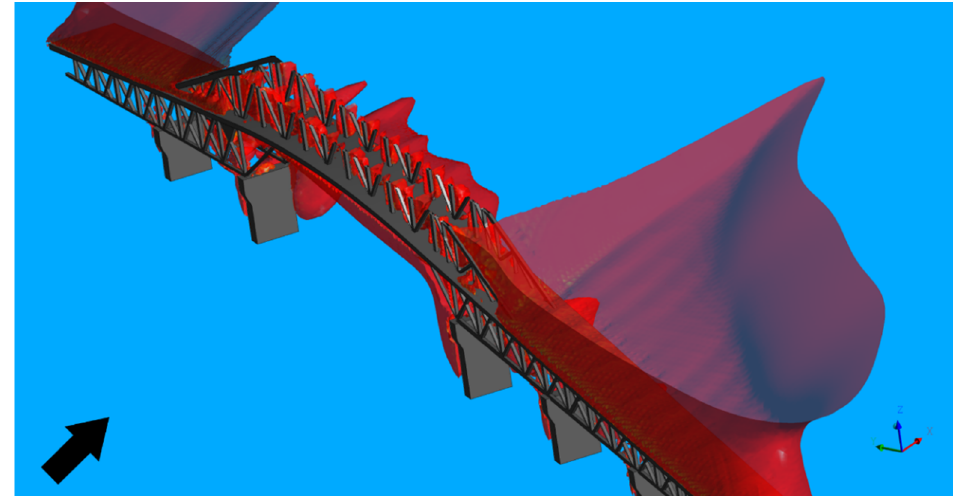
Figure 12. Velocity iso-surface showing the locations where the velocity is 18 m s − 1 . The top arch is removed from the visualisation to show the iso-surface on the road more clearly.